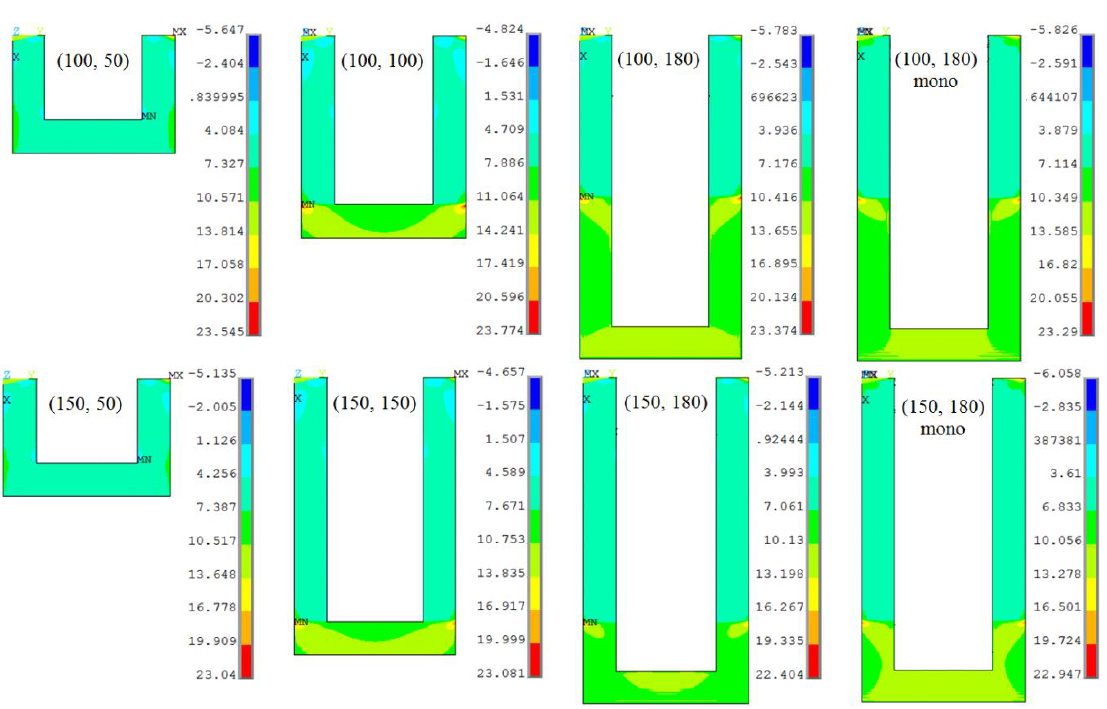
Figure 4. The longitudinal thermal stress distribution (MPa) in different ( l , l microcantilever designs for bias voltage 5